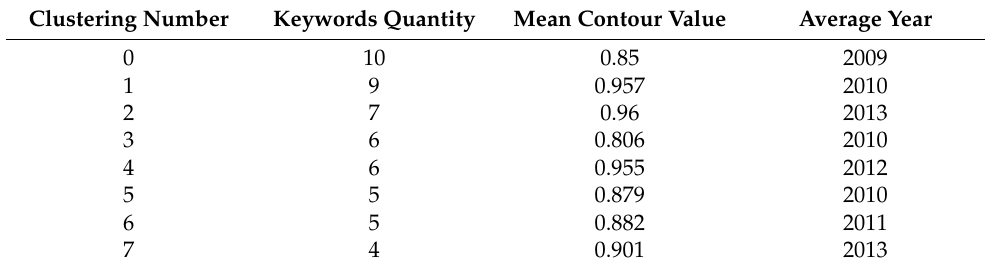
Table 4. Seven main clusters in the field of spatial planning based on WOSCC.